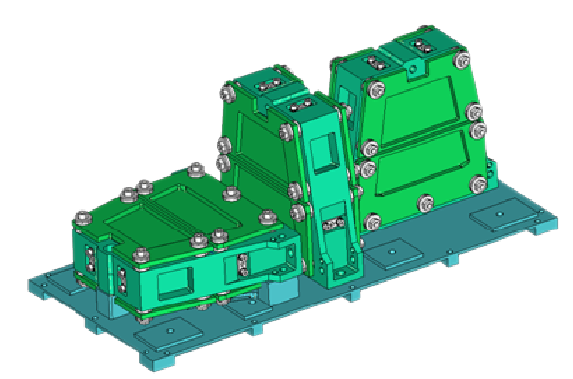
Figure 6. Rendering of the three ISA sensing elements arranged in a typical flight configuration. The acceleration vector on a reference point is reconstructed from the three measured components. Image courtesy of ISA BepiColombo Science